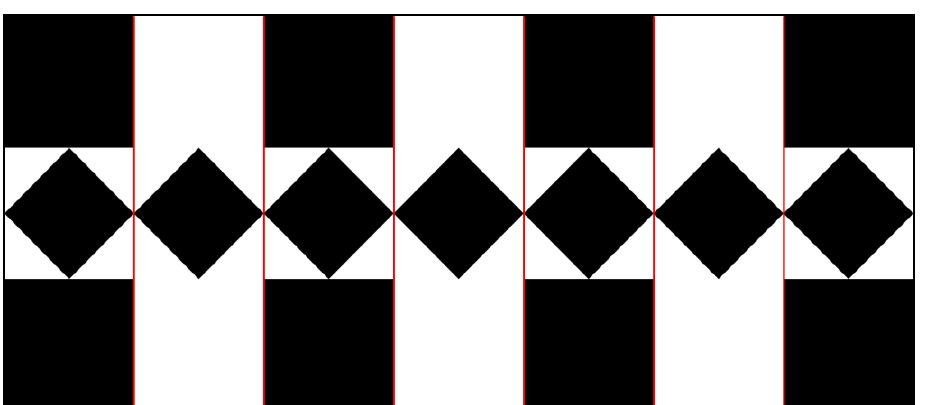
Figure 10. Verification using vertical segments of squares.